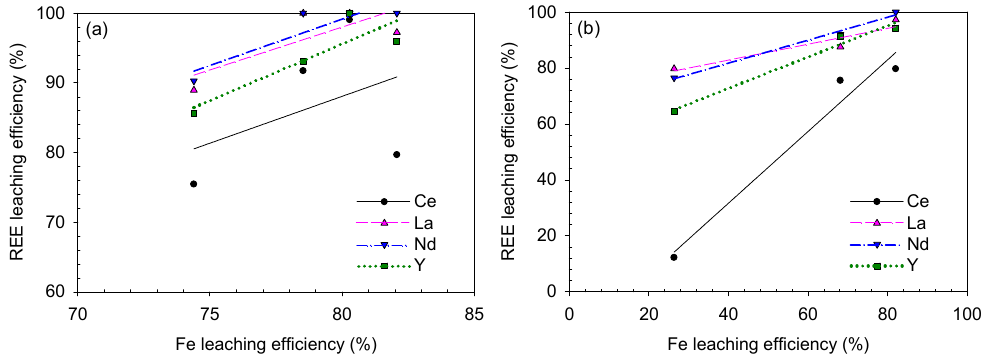
Figure 18. REE–Fe efficiency correlation for the caustic digestion–acid-leaching results based on ( a ) Figure 18. REE–Fe e ffi ciency correlation for the caustic digestion–acid-leaching results based on digesting NaOH solution concentration and ( b ) leaching HCl concentration . ( a ) digesting NaOH solution concentration and ( b ) leaching HCl Table 5. R 2 values of REE–Fe correlation curves based on the decomposition method and leaching condition .